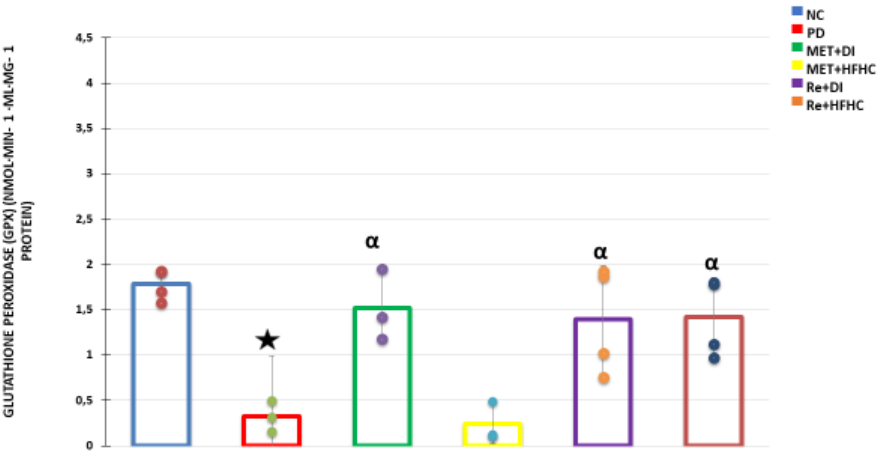
Figure 7. GPx activity in normal control (NC), prediabetic control (PD), metformin and diet intervention (MET + DI), metformin and high fat–high carbohydrate (MET + HFHC), rhenium (V) compound and diet intervention (Re + DI) and rhenium (V) compound and high fat–high carbohydrate (Re + HFHC) groups after 12 weeks of treatment. Values are presented as means ± SD and individual data points ( n = 6). * p < 0.05 by comparison with NC, α p < 0.05 by comparison with PD, MET + DI, MET + HFHC, Re + DI and Re + HFHC.